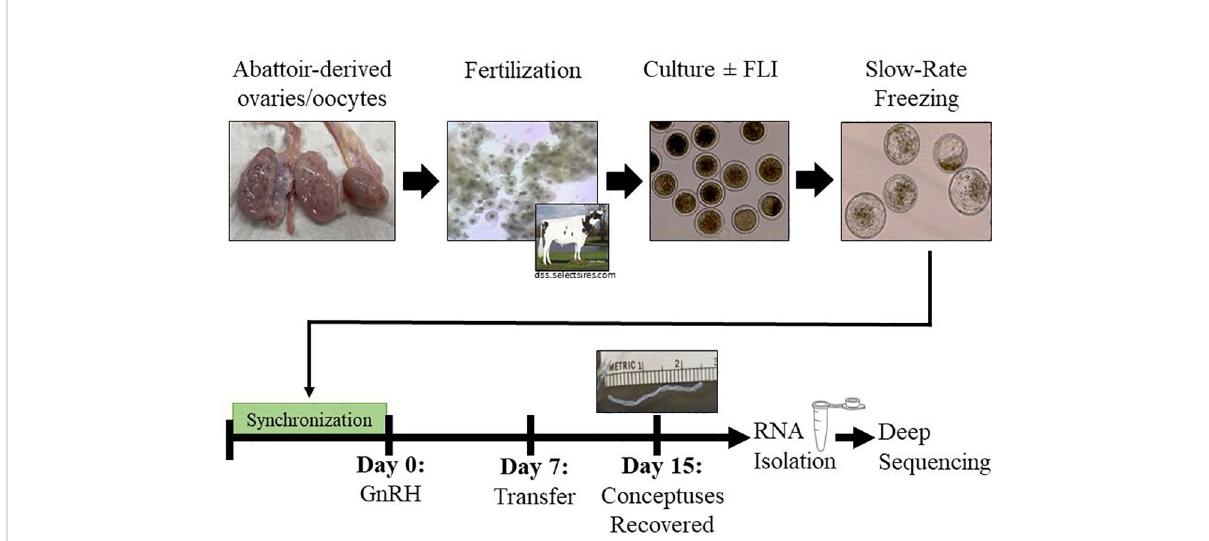
FIGURE 1 Experimental Design. Abattoir-derived oocytes were collected and matured for 22 hours before fertilization for 16-18 hours. After 7 days in culture (+/-FLI), blastocyst stage embryos were cryopreserved by slow-rate freezing. Groups of fi ve embryos were transferred into recipient females 7 days after the last administration of GnRH of a 5-day CO-Synch plus CIDR ® protocol. Conceptuses were recovered on day 15 and collected for transcriptomic